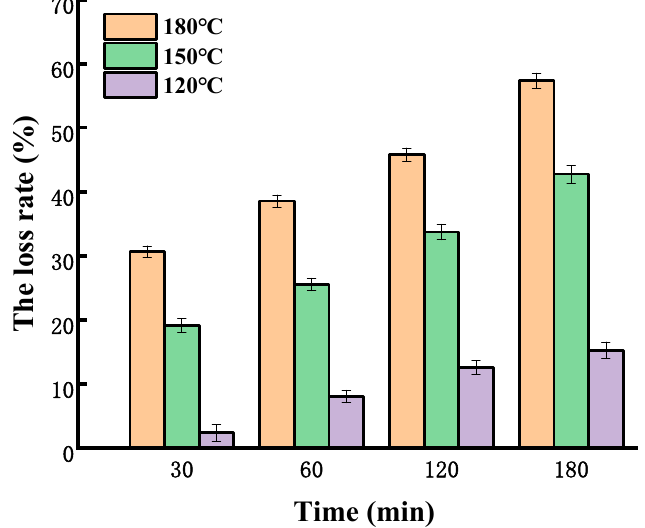
Figure 3. The loss rate of soybean germ phytosterols in olive oil.